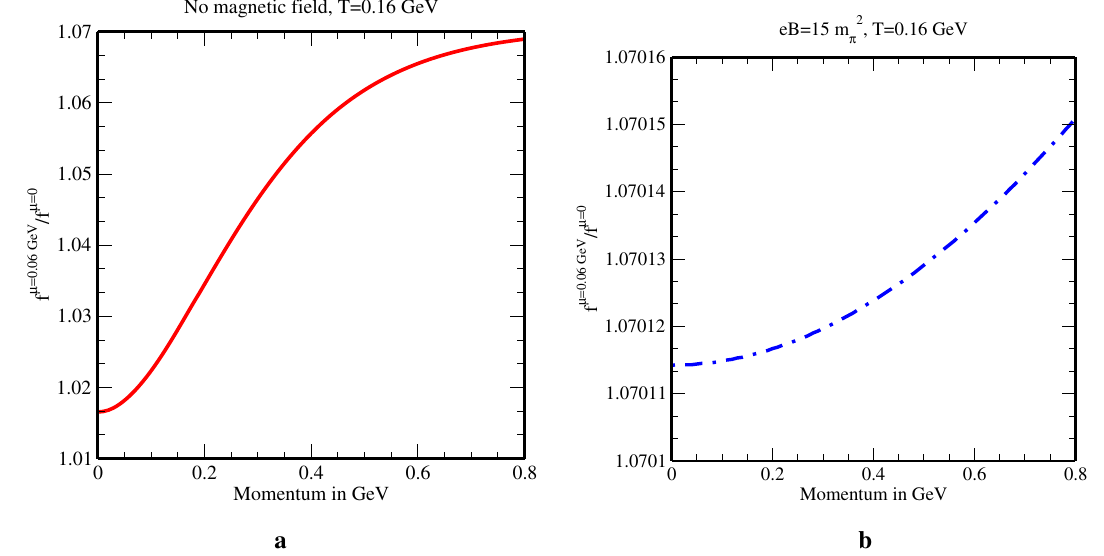
Fig. 1 Variations of the ratio of quark distribution function at μ = 0 . 06 GeV to its value at μ = 0 with momentum at low temperature in the a absence and b presence of strong magnetic field